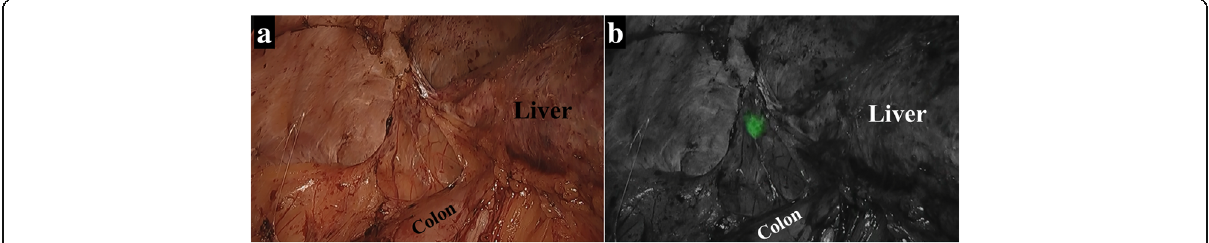
Fig. 2 a Laparoscopic view after dissection of the adhesion. The location of the tumor was unclear. b Endoscopic, indocyanine green (ICG) near-infrared fluorescence imaging using the 1588 AIM camera system. ICG fluorescence mode revealed clear green fluorescence at the tumor